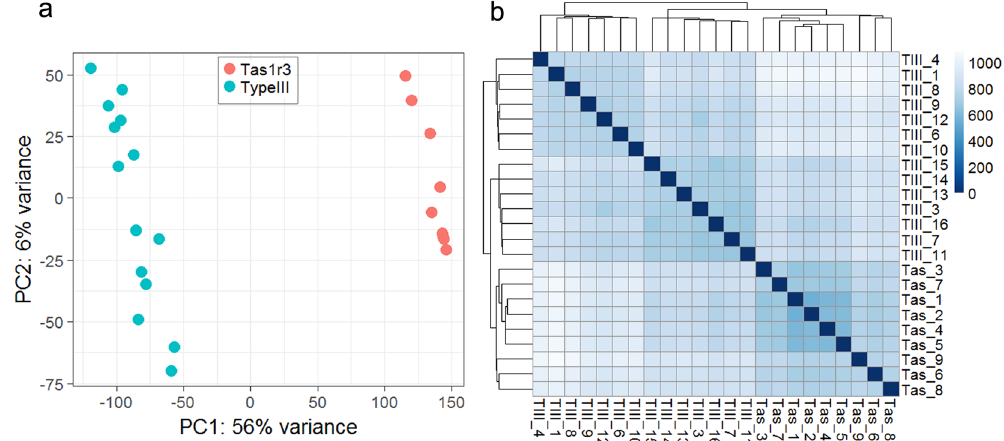
Figure 1. Comparisons of global gene expression among individual Tas1r3 + cells and type III cells. ( a ) Principal component analysis of Tas1r3 + cells (red) and type III cells (blue). ( b ) Hierarchical cluster analysis and heat map of Euclidean distances (shown in Table S4) among individual Tas1r3 + (Tas_1 through Tas_9) cells and type III cells (TIII_1 through TIII_16). Darker shades of blue indicate smaller sample distance and higher relatedness between libraries (scale bar, right). Both analyses show that transcriptomes from cognate cells are more similar to each other than to transcriptomes from cells belonging to the different